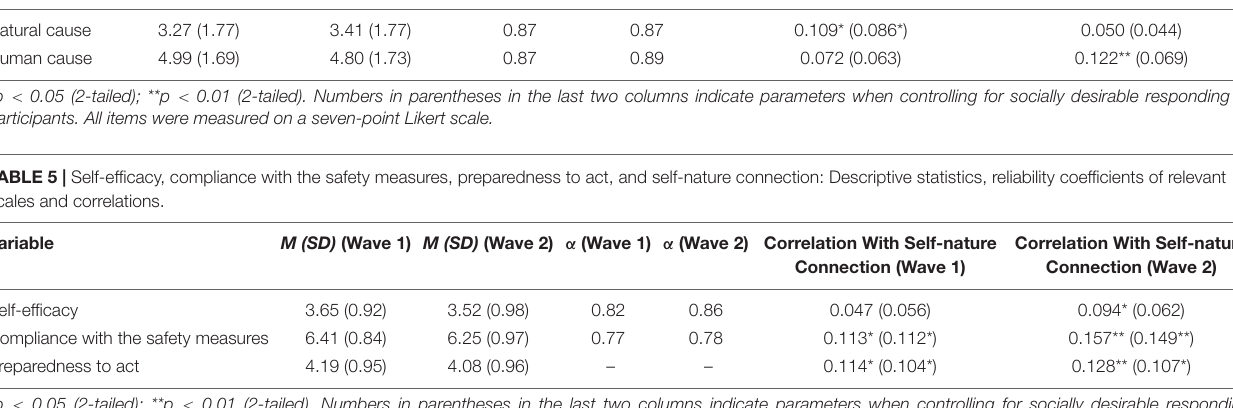
TABLE 4 | The perceived origin of the coronavirus and self-nature connection: Descriptive statistics, reliability coefficients of relevant scales and correlations. Variable